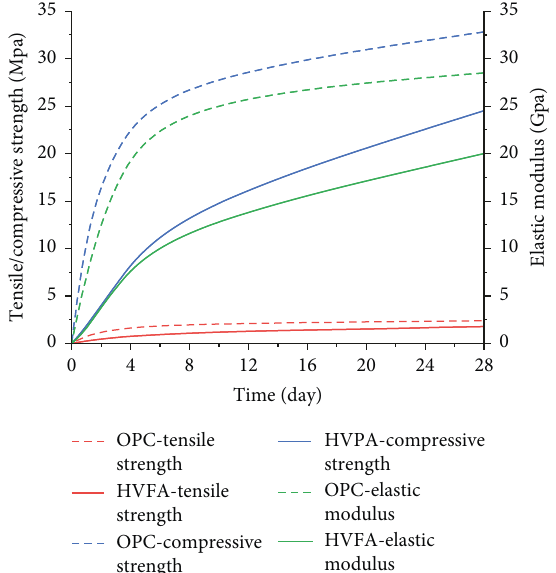
Figure 3: Flowchart of the modeling